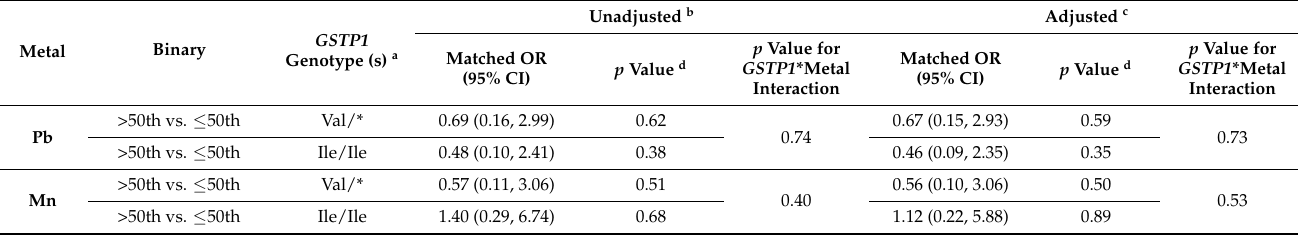
Table 5. Interaction of GSTP1 genotypes with blood Lead (Pb), Manganese (Mn) concentration (under a dominant genetic